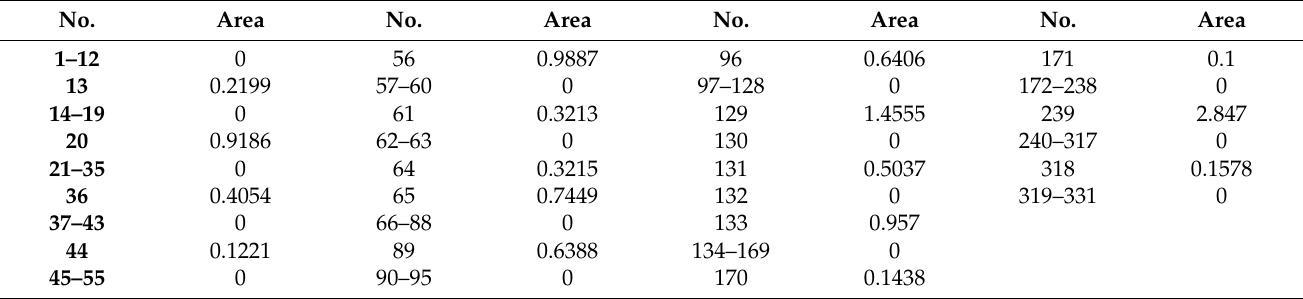
Table 6. Optimal design of the 622-bar